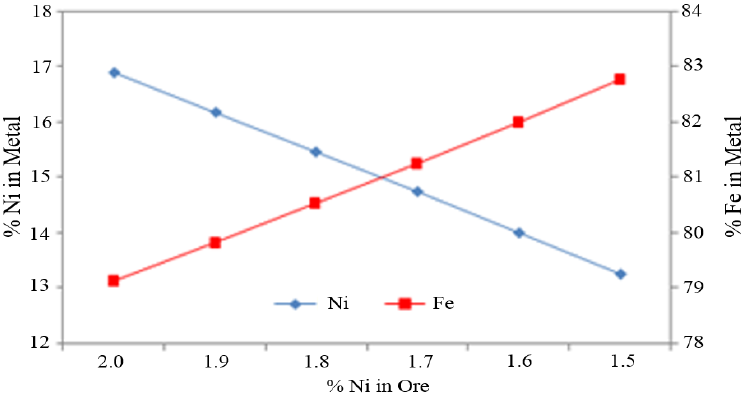
Figure 5. Effect of Metal Composition when Ni Composition Decreases.